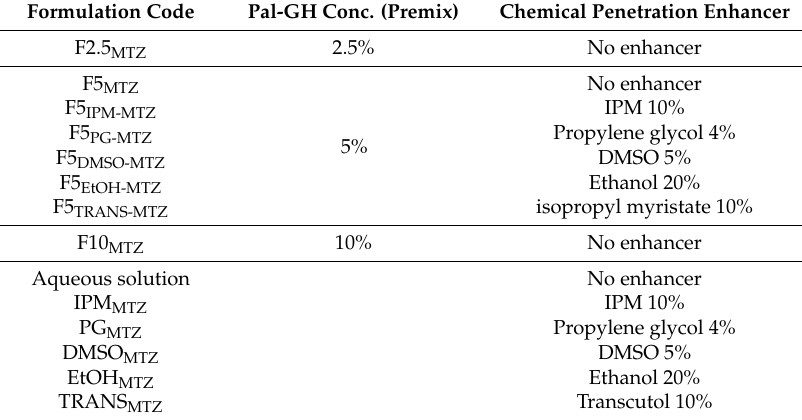
Table 1. Composition of the N -Palmitoyl-Glycine-Histidine (Pal-GH) gel formulations and metronidazole (MTZ) solution with or without a chemical enhancer prepared in this experiment. IPM = isopropyl myristate; PG = propylene glycol; ethanol; DMSO = dimethyl sulfoxide; and TRANS = isopropyl